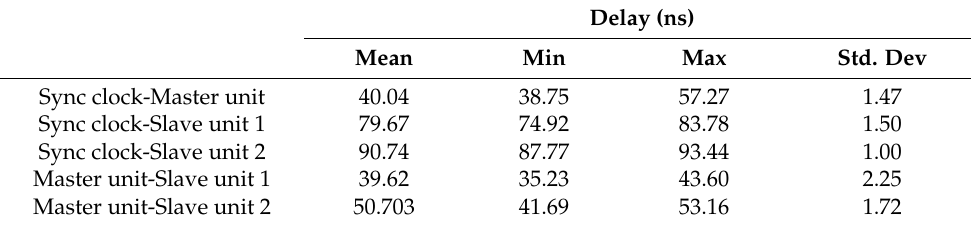
Table 3. Clock delays between sync clock and sampling clocks including propagation